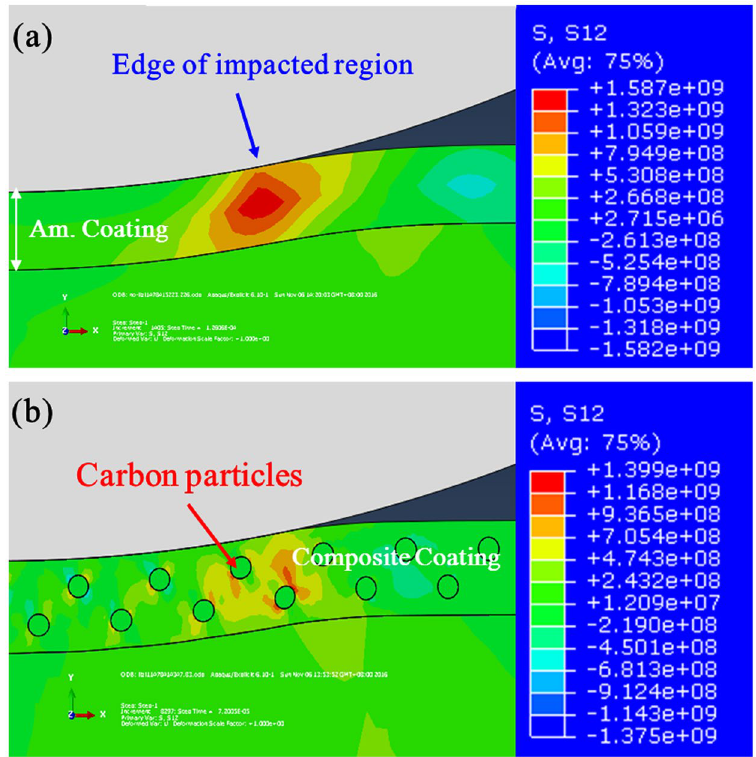
Figure 8. Contour plots of shear stress (S12) in ( a ) the amorphous coatings and ( b ) composite coatings reinforced with carbon particles at the maximum displacement of impact